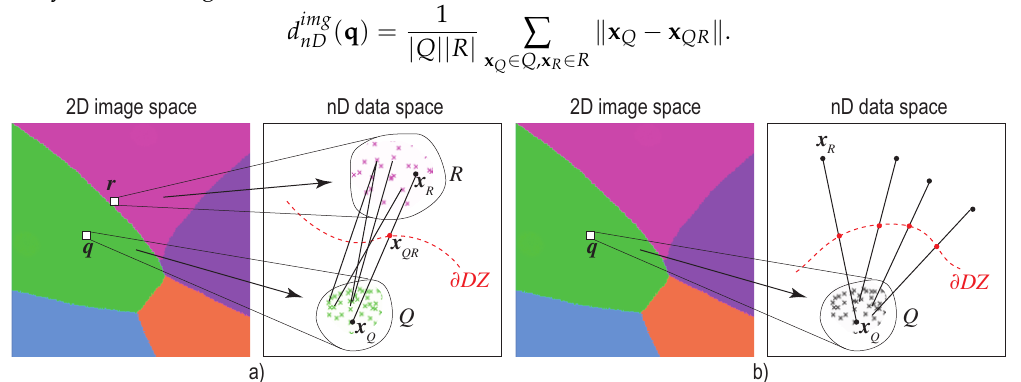
Figure 9. Estimation of distance-to-boundary d img